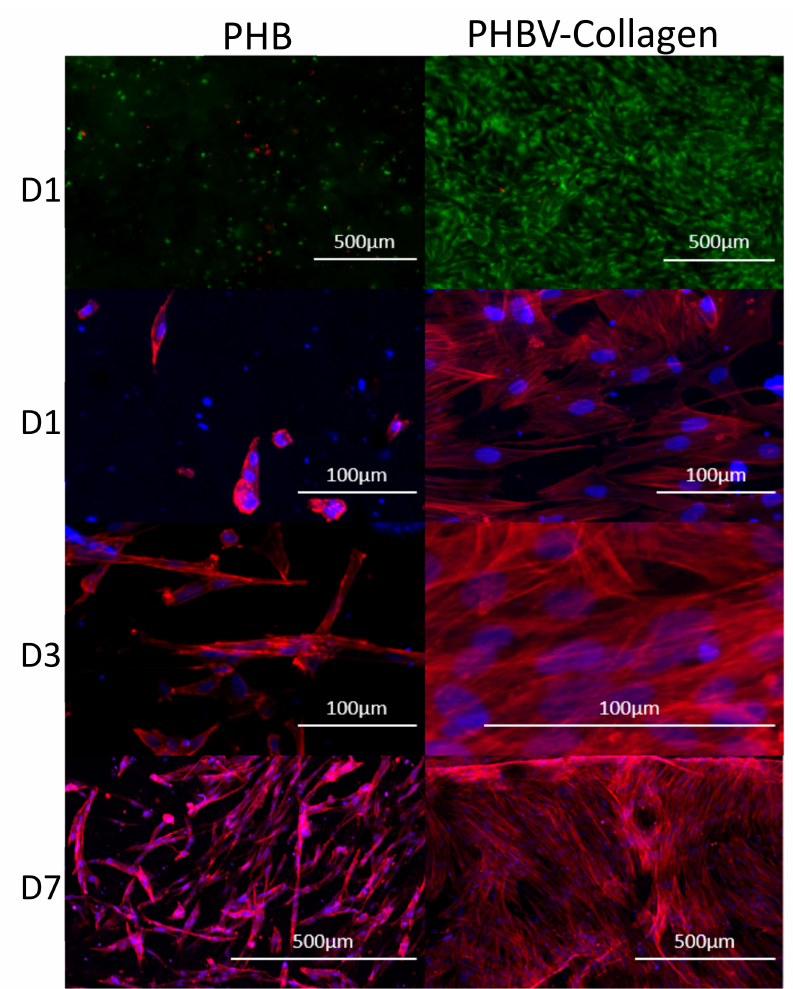
Figure 8. Cytotoxicity, cell viability, and cell morphology of Neo-NHDF cells cultured on force-spun PHBV sca ff olds with and without collagen. Immunofluorescent images of Neo-NHDF cells stained with the Live / Dead membrane integrity assay (green—viable cells, red—dead cells, 5 × magnification). Confocal microscope images showing the morphology of the Neo-NHDF cells seeded on PHBV and PHBV-Collagen sca ff olds on days 1 (D1), 3 (D3), and 7 (D7) (red—phalloidin, and blue—DAPI, 5 × and 10 ×